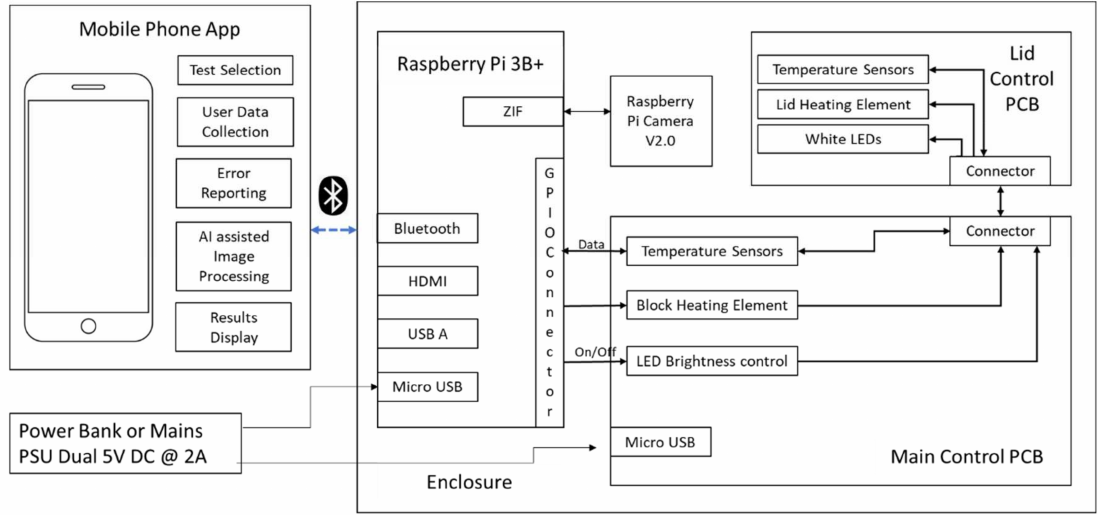
Figure 2. Schematic diagram of the ultralow-cost molecular diagnostic device for SARS-CoV-2